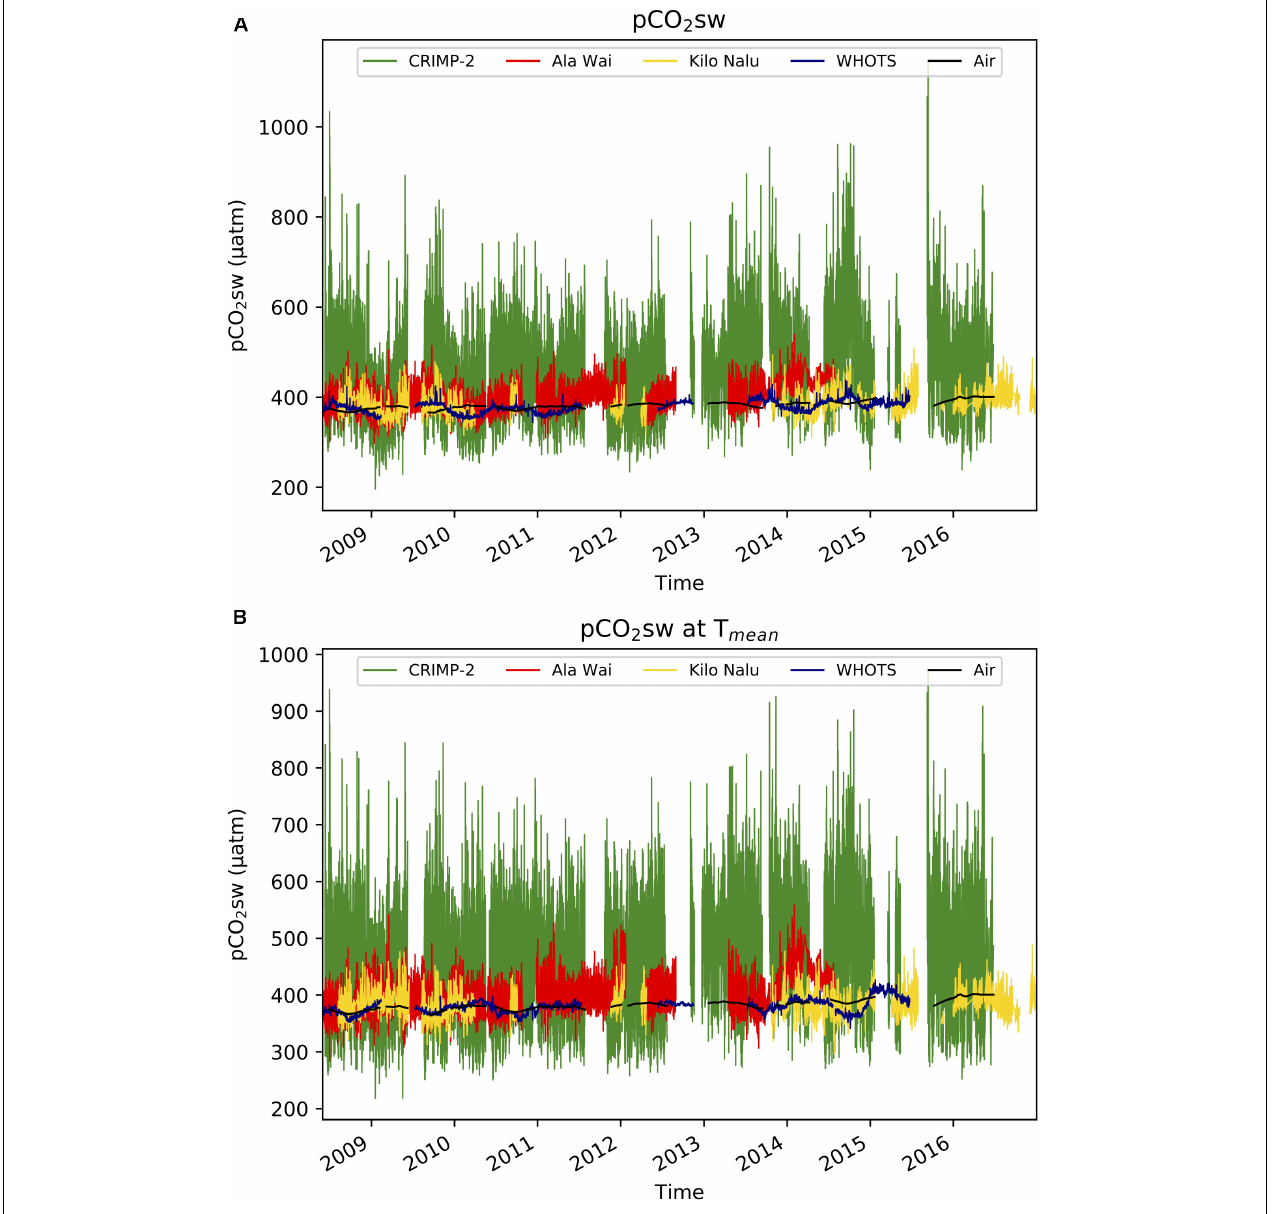
FIGURE 2 | Time-series of in situ (3-hourly) p CO 2 sw in µ atm at CRIMP2, Ala Wai, Kilo Nalu, and WHOTS from June 2008 to December 2016. Weekly mean air p CO 2 at CRIMP2 is displayed in black. (A) p CO 2 sw at all sites. (B) p CO 2 sw normalized to the mean annual seawater temperature ( p CO 2 at T mean